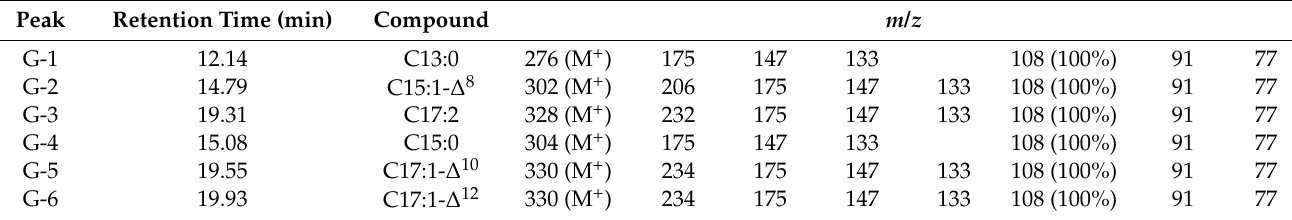
Table 1. EI mass fragments of isolated ginkgol monomers.